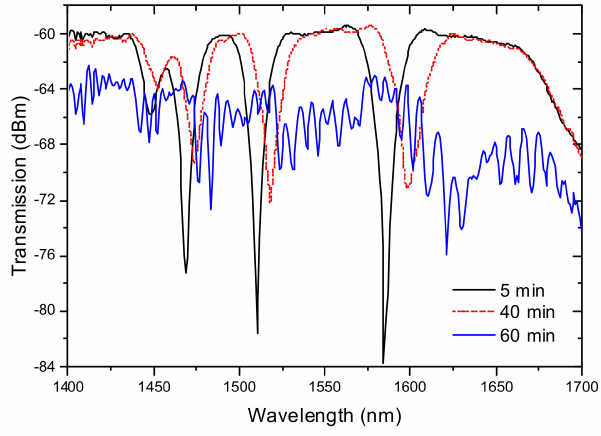
Figure 10. Annealing at 1190 ◦ C of a 430 µ m LPFG inscribed in the Corning DSF fiber. Reprinted from [86].